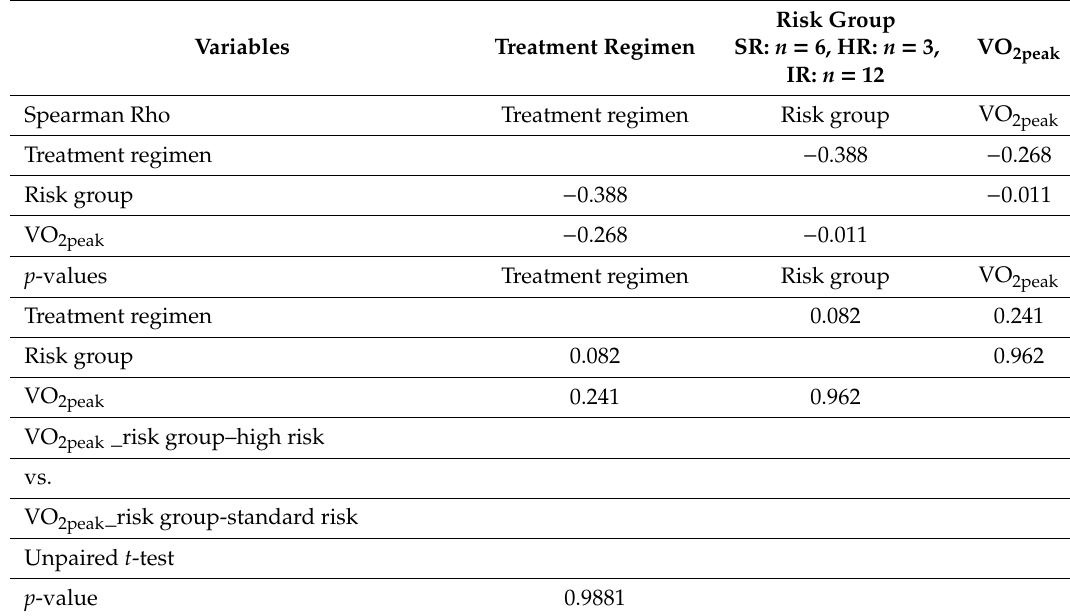
Table 6. The relationship between the level of exercise capacity (VO 2peak ) and the risk group (SR, standard risk; IR, intermediate risk; and HR, high